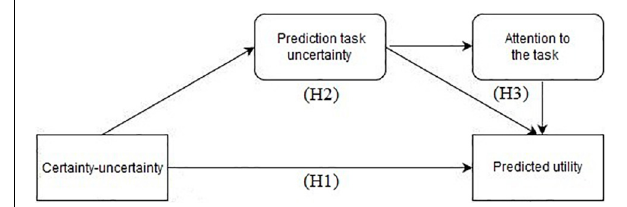
FIGURE 1 | Hypothesized conceptual